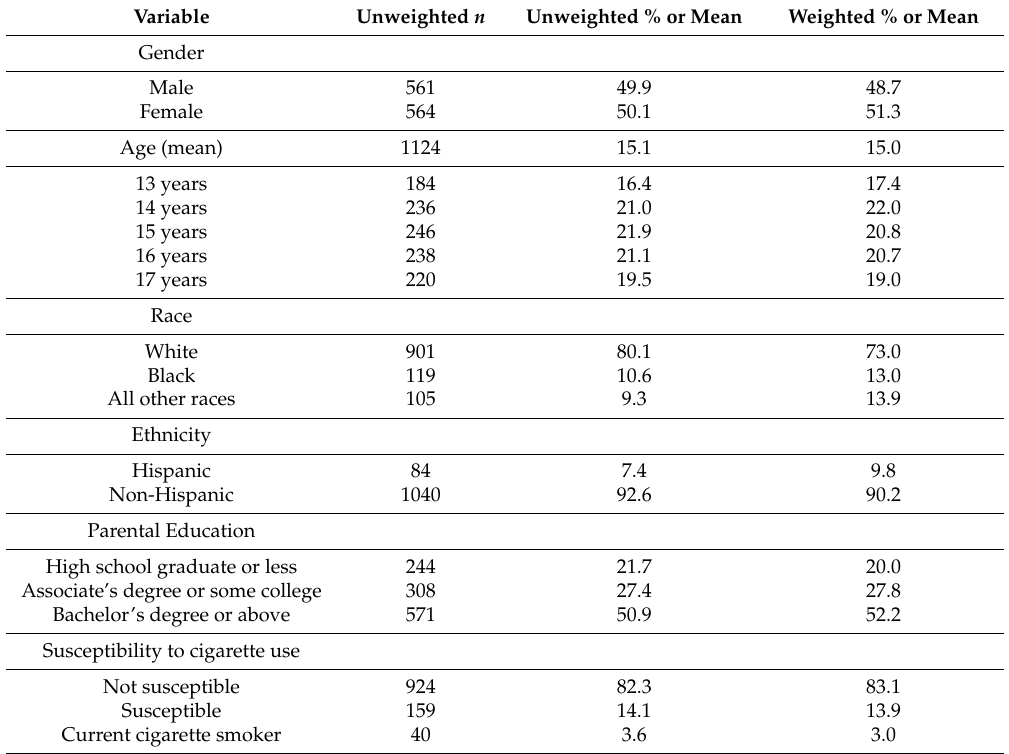
Table 1. Sample Characteristics ( n =